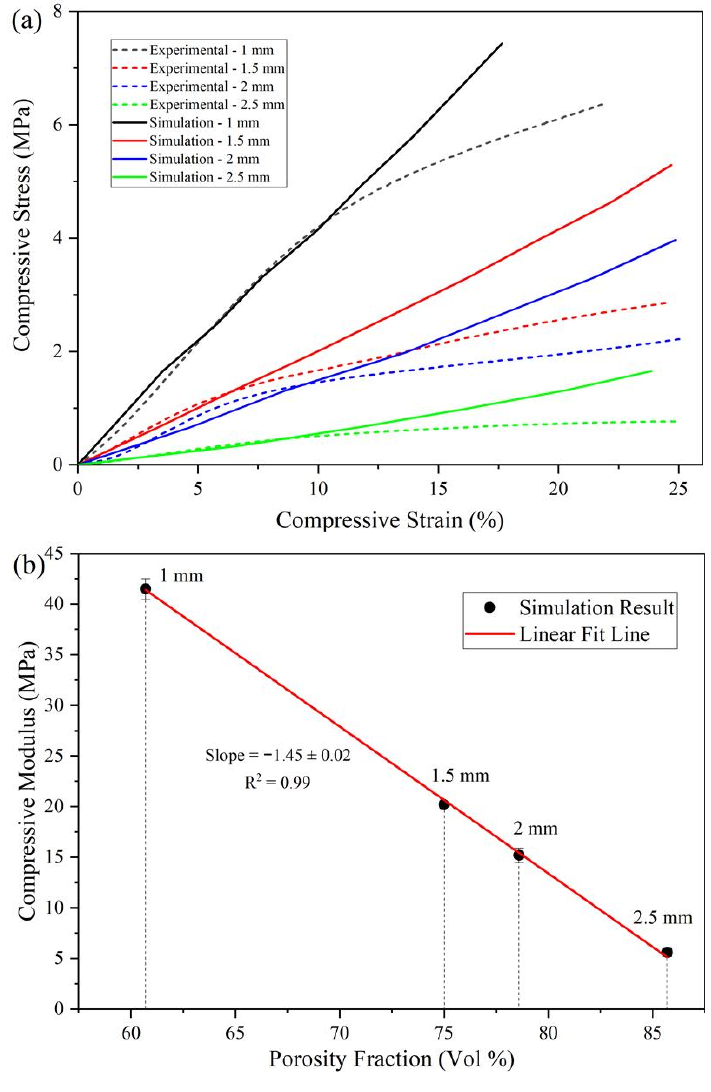
Figure 8. Numerically obtained compressive modulus. ( a ) Compressive modulus of printed scaffolds considering different filament distances (N = 4). ( b ) The correlation between compressive modulus and the scaffold designed porosity. Table 2. Comparison between numerically and experimentally obtained compressive